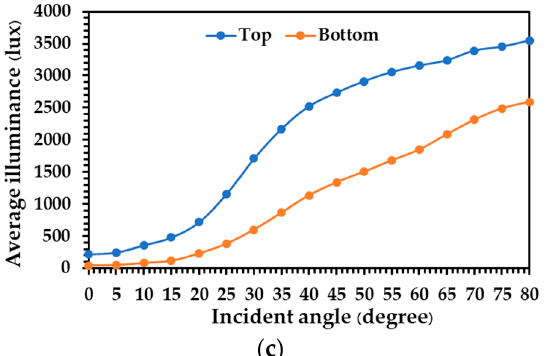
Figure 7. Average illuminance at the top and bottom end positions of aluminum alloy tube with a diameter of ( a ) 0.20 m, ( b ) 0.25 m, and ( c ) 0.30 m.